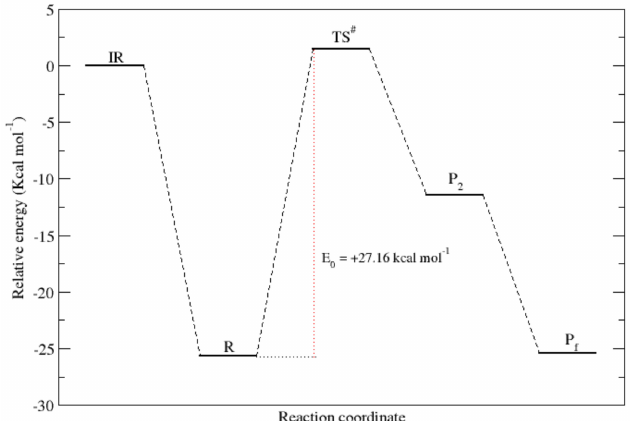
Figure 3. Reaction energies of the Gly-TS4 path with respect to isolated reactants as computed using ZPE corrected electronic